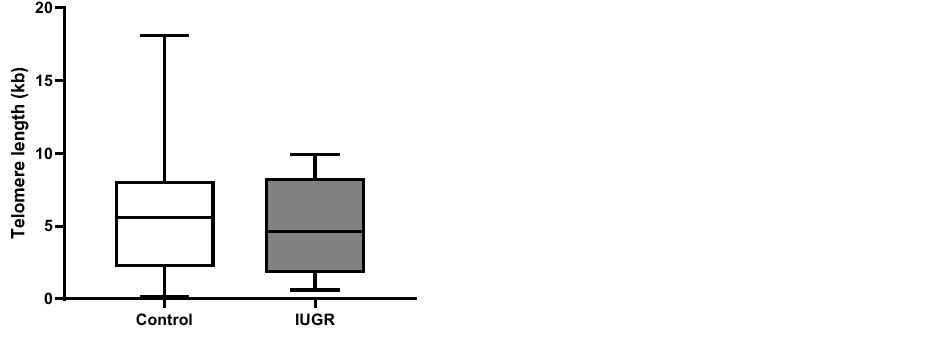
Figure 3. Absolute telomere length in IUGR. ATL in placental tissue showed no significant changes in IUGR compared with controls. Data are represented as mean aTL ± SD, p < 0.05. Table 3. The Crude and adjusted association between placental absolute telomere length (aTL) in kbp for IUGR placentas compared with controls. a Adjusted for maternal age, BMI, gestational age, ICC, and foetal sex. Abbreviations: 95% CI = 95% confidence interval, BMI = body mass index, ICC = individualised customised centile, aTL = absolute telomere